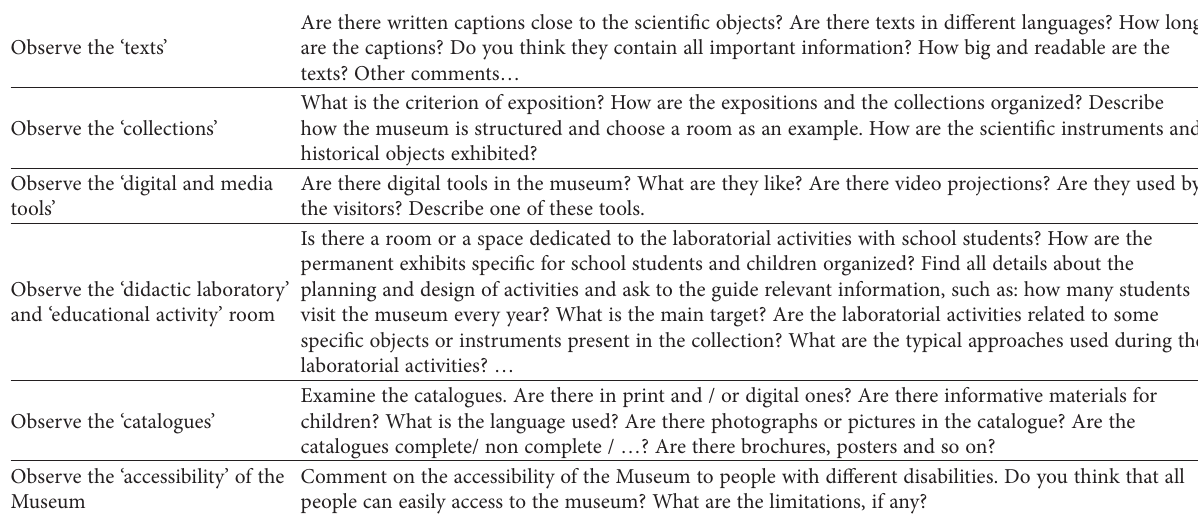
Table 1. ‘Guided questions’ given to the students before visiting the Museum.